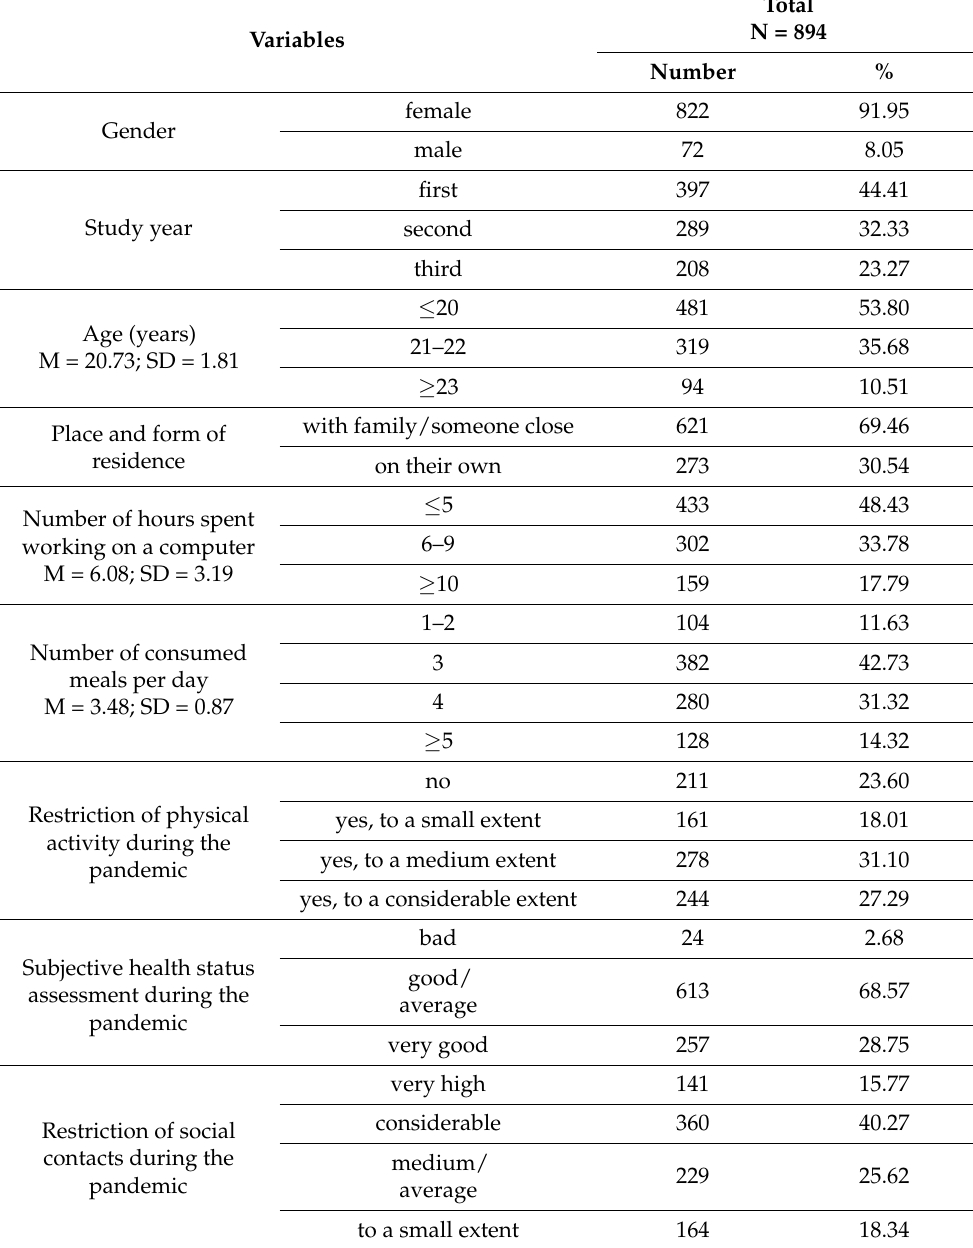
Table 1. Sociodemographic characteristics of the study